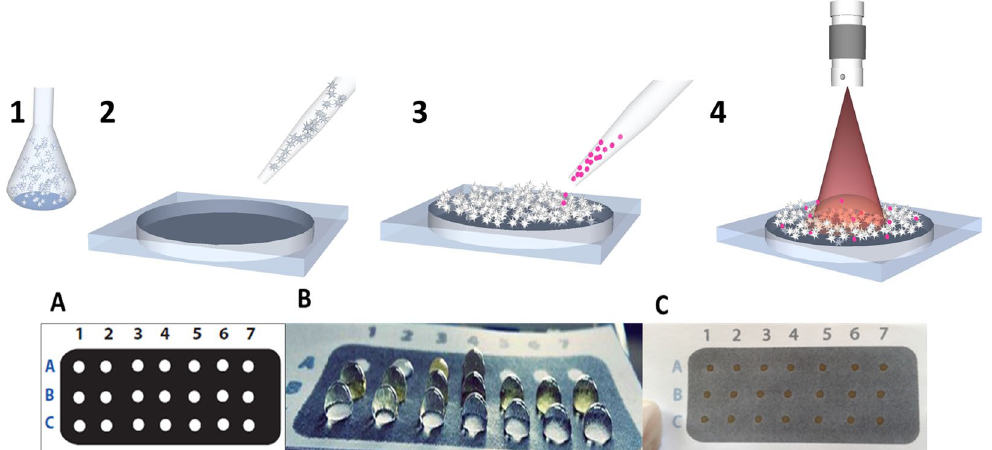
Figure 1. Top: Schematic representation of the fabrication process of the plasmonic SERS paper substrates: (1) Synthesis of (spherical and star-shaped) silver nanoparticles; (2) formation of wells on (Whatman no. 1 and office) paper followed by deposition of nanoparticles in the wells by drop-casting; (3) addition of R6G; (4) analysis of SERS signal using a 633 nm laser. Bottom : Wells pattern design on paper, before and after deposition of AgNSs. ( A ) Front view of the paper surface with wells presenting a diameter of 2 mm. ( B ) Photograph of the plasmonic paper substrate after drop-casting of the AgNSs solution and ( C ) after